Question: Provide a publication-style caption for this figure.
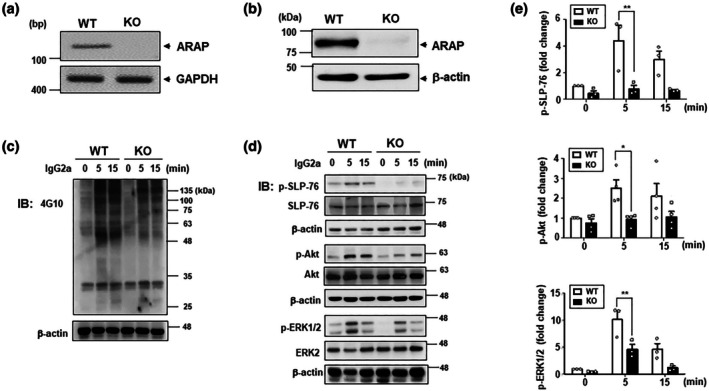
Answer: ARAP is expressed in BMDCs and contributes to FcγR‐induced proximal signaling. (a) RT‐PCR analysis of ARAP gene expression in WT and KO BMDCs. GAPDH was used as an internal control. (b) Immunoblotting (IB) analysis confirming the absence of ARAP expression in KO BMDCs. β‐Actin was used as a loading control. Data are representative of three independent experiments. ARAP, activation‐dependent, raft‐recruited ADAP‐like phosphoprotein. (c) Immunoblot analysis of global tyrosine phosphorylation following FcγR cross‐linking (IgG2a) in WT and KO BMDCs at the indicated time points. Overall tyrosine phosphorylation was reduced, but not abolished, in ARAP‐KO BMDCs compared to WT cells. β‐actin was used as a loading control. (d) Immunoblot analysis showing reduced phosphorylation levels of SLP‐76, Akt, and ERK1/2 in ARAP‐KO BMDCs compared to WT BMDCs. Corresponding total protein levels (SLP‐76, Akt, ERK1/2) are shown for each blot. β‐actin was included as a loading control. Data are representative of three independent experiments. (e) Quantitative analysis of phosphorylation of SLP‐76 (p‐SLP‐76), Akt (p‐Akt), and ERK1/2 (p‐ERK1/2). Band intensities were measured using ImageJ, and phosphorylation levels were normalized to their respective total protein levels. Values were expressed relative to unstimulated WT BMDCs. Data represent the mean ± s.e.m. of three independent experiments. Statistical significance was determined by two‐way ANOVA and Bonferroni's post hoc tests. * P < 0.05, ** P < 0.01.